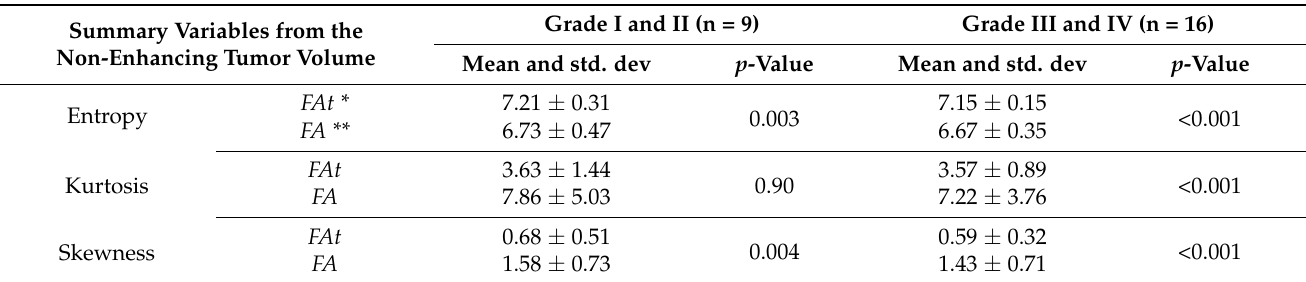
Table 3. Comparison of fractional anisotropy summary variables with and without free water corrections in the non- enhancing tumor region. Reported p ‐ values were computed according to the paired t ‐ test and were adjusted with the Bonferroni method (significance threshold < 0.05).